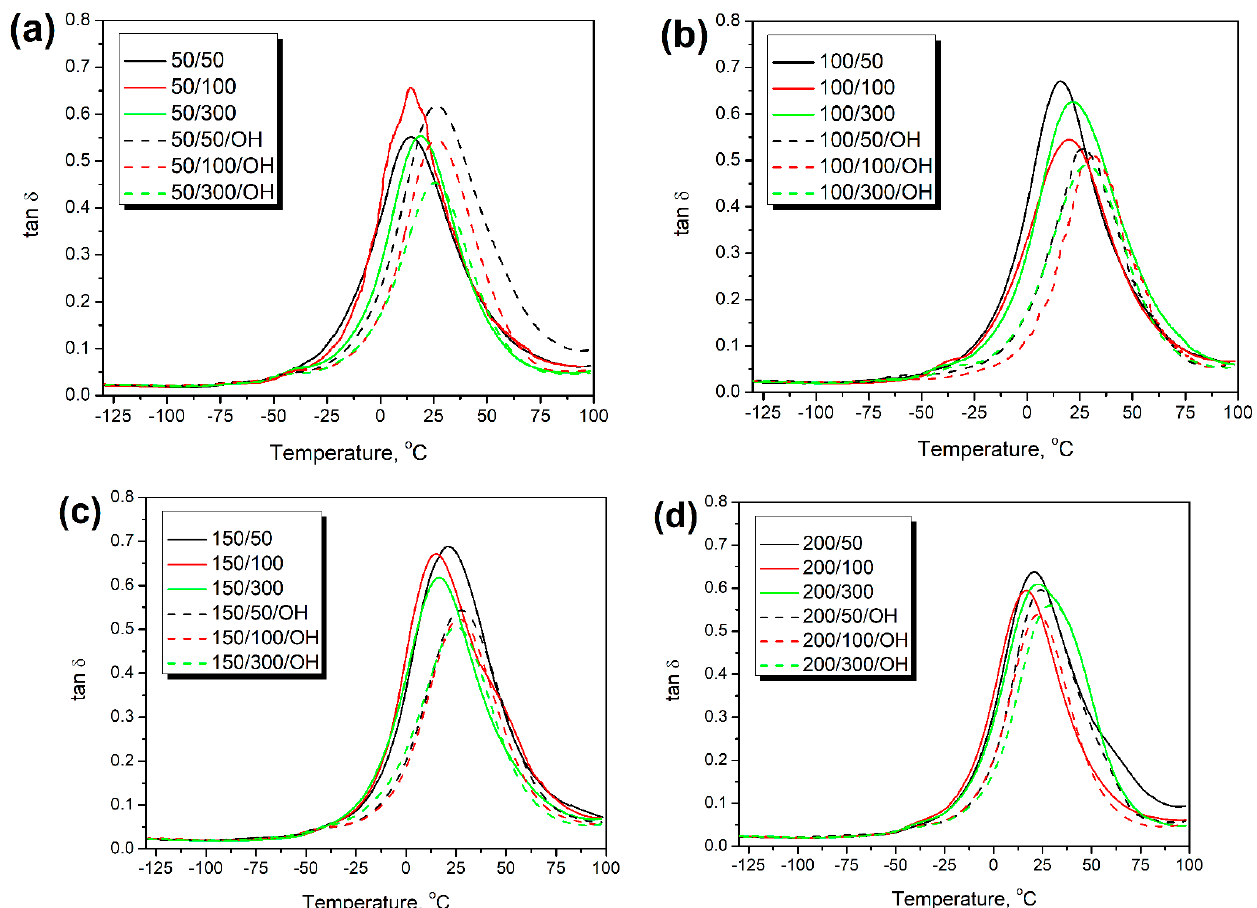
Figure 10. Temperature plots of loss tangent for composites containing GTR modified at ( a ) 50 °C, ( b ) 100 °C, ( c ) 150 °C, and ( d ) 200 °C. ( b ) 100 ◦ C, ( c ) 150 ◦ C, and ( d ) 200 ◦